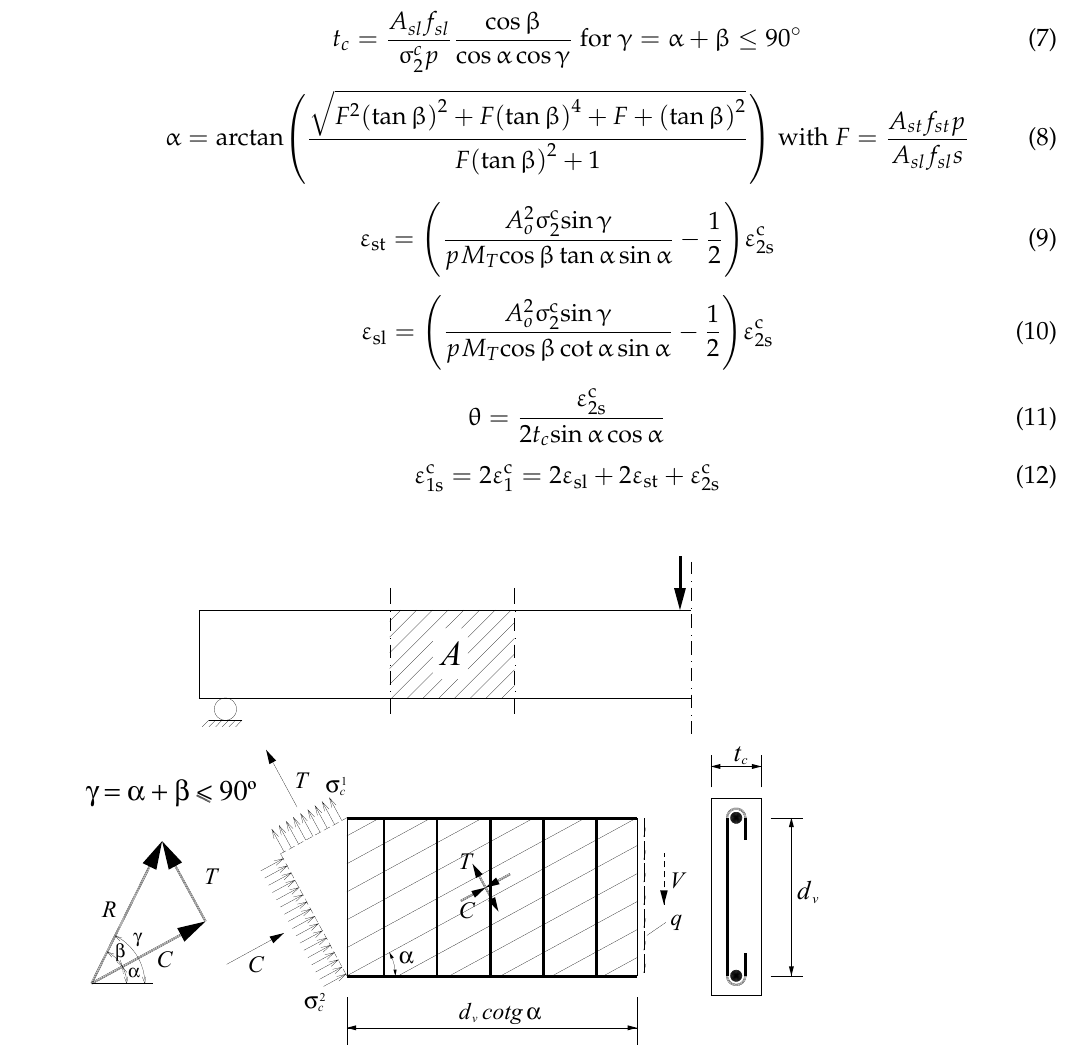
, as illustrated in Figure (cid:3021) induces a (cid:3021)